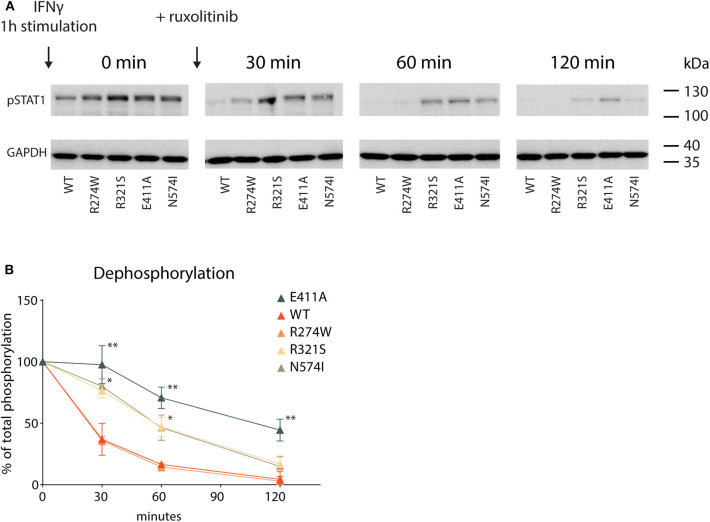
Dephosphorylation kinetic (A) Representative Western blot of U3A cell lysates. Cells were first treated with IFNγ (1 U/μl) for 1 h (minute 0) and then DMEM medium supplemented with ruxolitinib (10 μM) was added. Whole cell lysate was collected 0, 30, 60, or 120 min after ruxolitinib addition. (B) Quantification of pSTAT1 levels, plotted as % of maximum phosphorylation measured at minute 0. Statistical analysis: Student's t-test, comparing every time point to the corresponding WT. *P < 0.05; **P < 0.01.